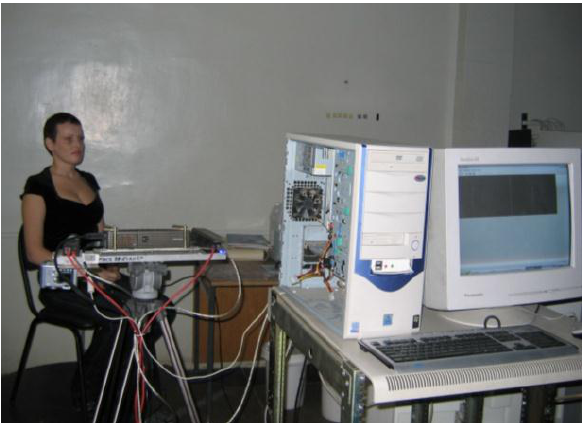
Figure 4. 3D face model